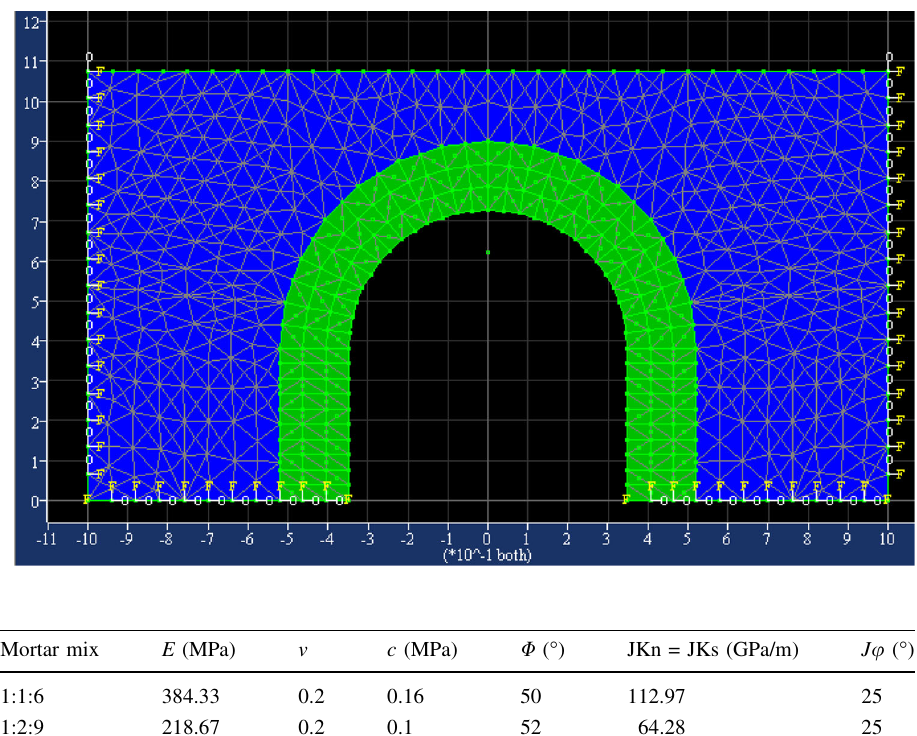
Fig. 3 UDEC model grids with